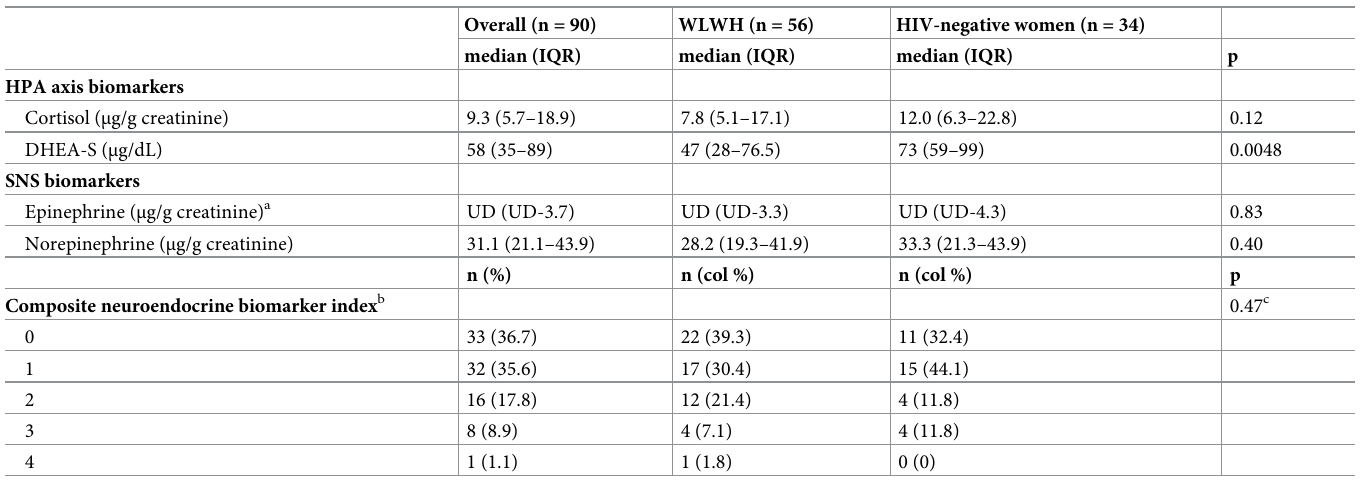
Table 4. Distribution of neuroendocrine biomarkers by HIV serostatus (n = 90).